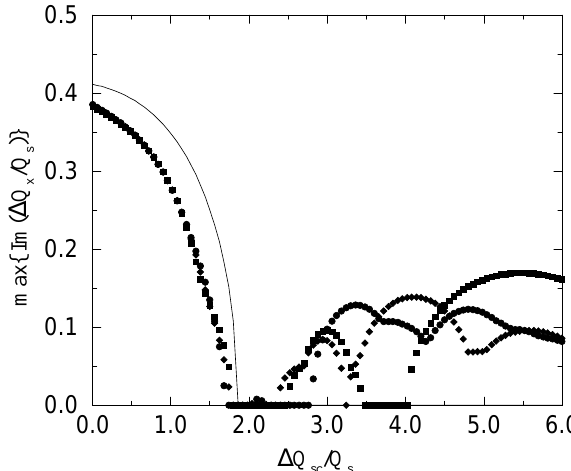
FIG. 2. Largest value of Im (cid:115) D (cid:81) (cid:120) (cid:121) (cid:81) (cid:115) (cid:100) as a function of D (cid:81) (cid:115)(cid:99) (cid:121) (cid:81) (cid:115) and (cid:109) max for a Gaussian density and simple wake. The wake is 50% larger than that needed to produce instability for D (cid:81) (cid:115)(cid:99) (cid:173) (cid:48) : (cid:109) max (cid:173) (cid:49) , solid line; (cid:109) max (cid:173) (cid:53) , squares; (cid:109) max (cid:173) (cid:49)(cid:48) , circles.